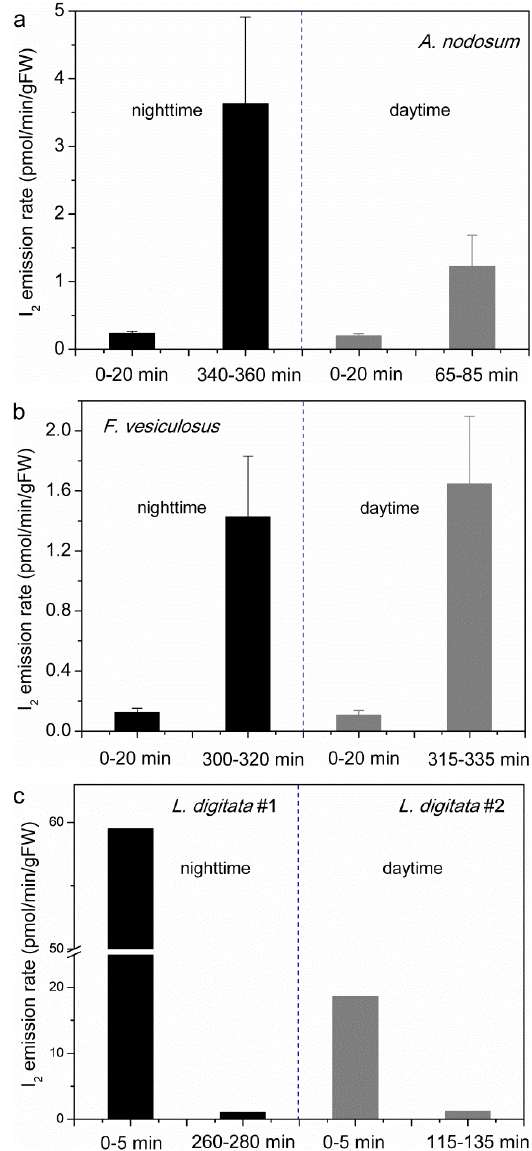
Fig. 4. The time-dependent I 2 emission rates of A. nodosum (a) , F. vesiculosus (b) and L. digitata (c) at daytime and nighttime when subjected to ambient air exposure in a flow chamber at Mweenish Bay. Note the difference in scale of L. digitata emissions and the lack of error bars in (c) as only one sample was taken for individual